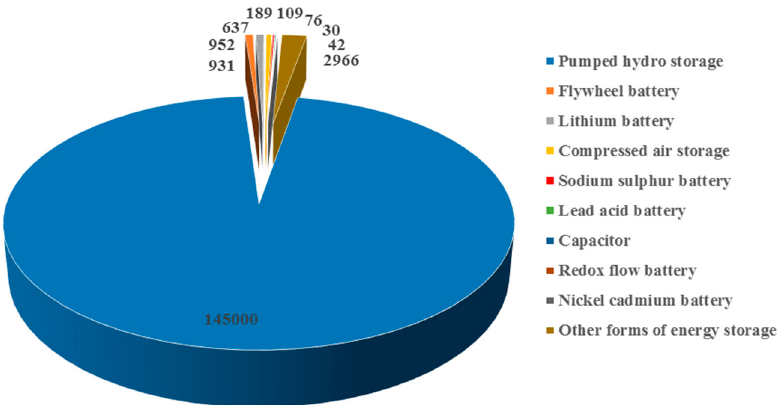
Figure 1. Installed capacity of various storage technologies in global electricity storage system (Unit: MW, Sources: Report issued by the International Renewable Energy Agency—“Re-Thinking Energy 2017”).